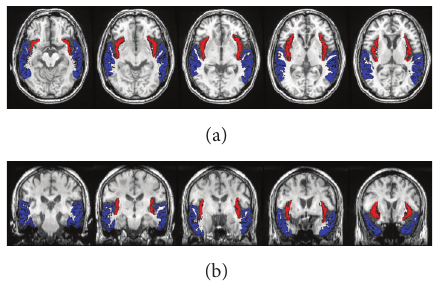
Figure 3: Map of volumes of interest on brain magnetic resonance imaging. (a) Axial view. (b) Coronal view.